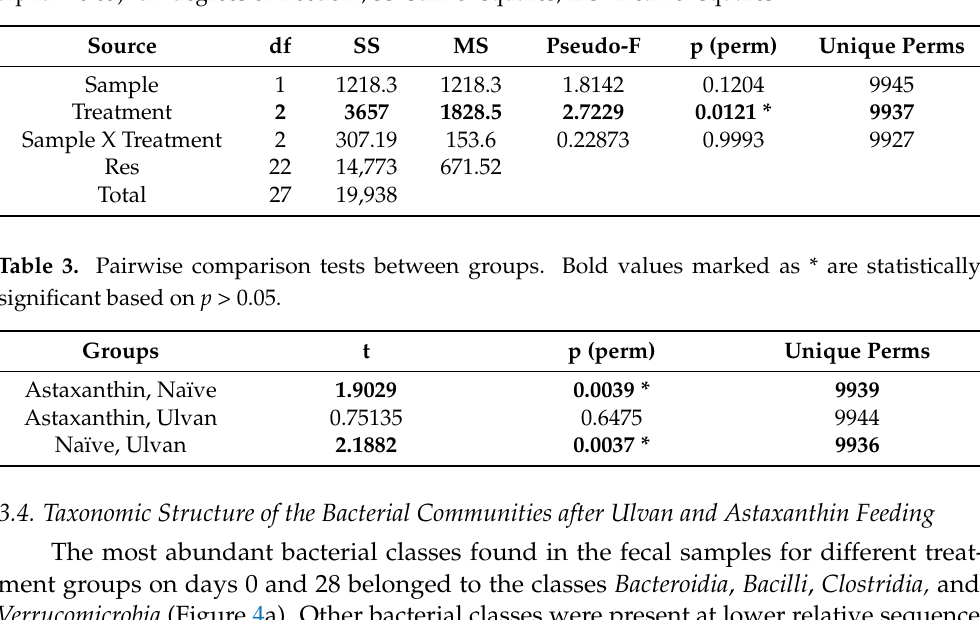
Figure 3. Multidimensional scaling (MDS) plot of bacterial community structure differences upon ulvan and astaxanthin feeding, based on sample type, that is, time-based ( a ) and fecal and caecum samples ( b ), at Day 0 and Day 28. Table 2. PERMANOVAs based on Bray–Curtis (BC) similarity measure for square-root transformed abundances of all mice fecal and caecum samples collected on day 28. p -values were calculated using 9999 permutations under a residual model. Bold and * indicates statistically significant values (at alpha = 0.05). df: degrees of freedom; SS: sum of squares; MS: Mean of squares.